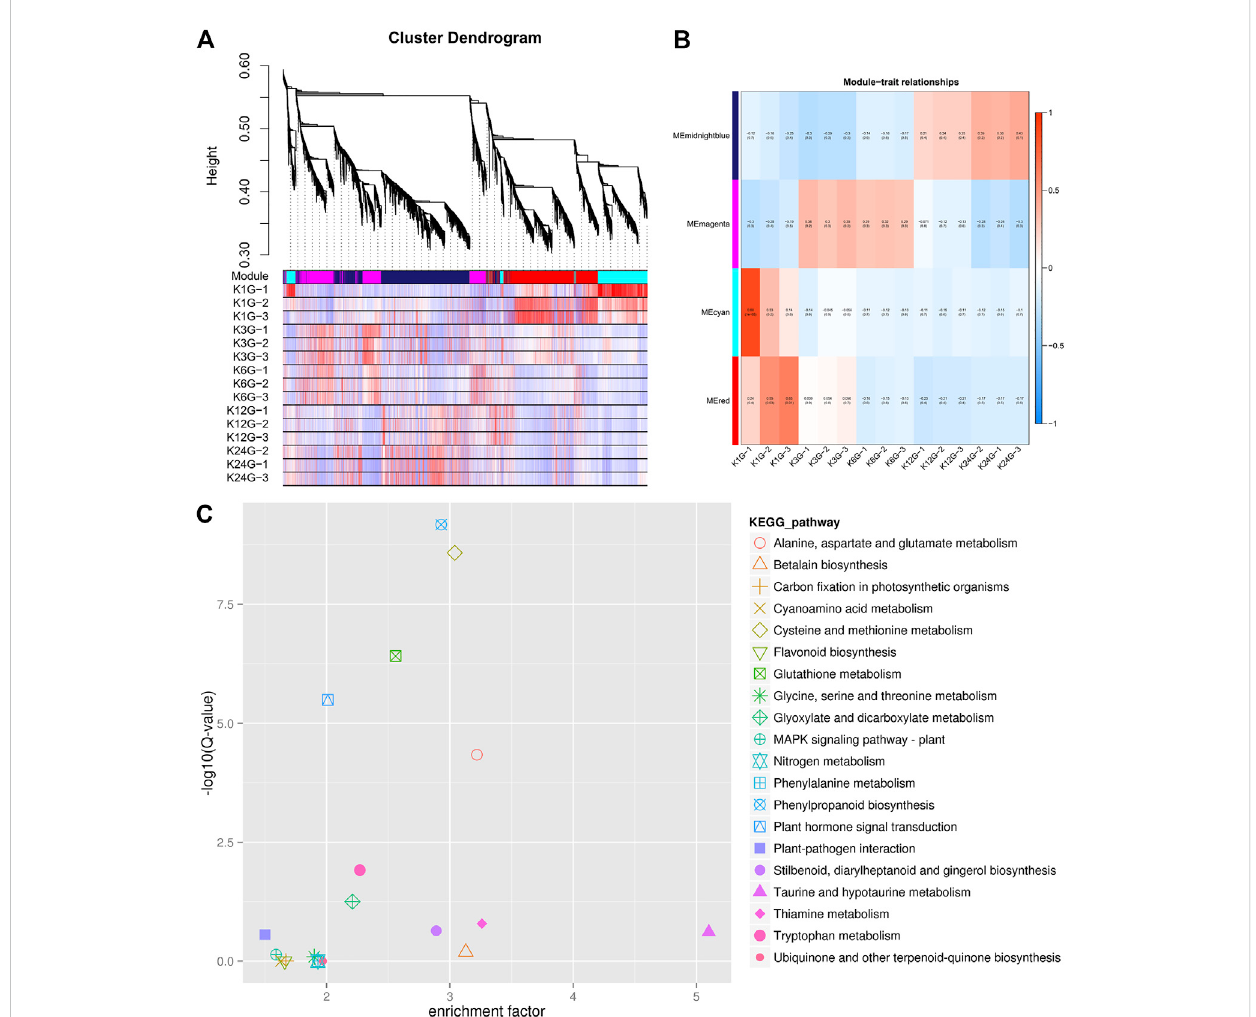
FIGURE 5 WGCNA analysis of root tissue with salt tolerance. (A) Cluster dendrogram of all 15 libraries at fi ve time points in root tissue. (B) Module – trait relationships for different modules with salt tolerance. (C) KEGG enrichment analysis of the green-yellow module.